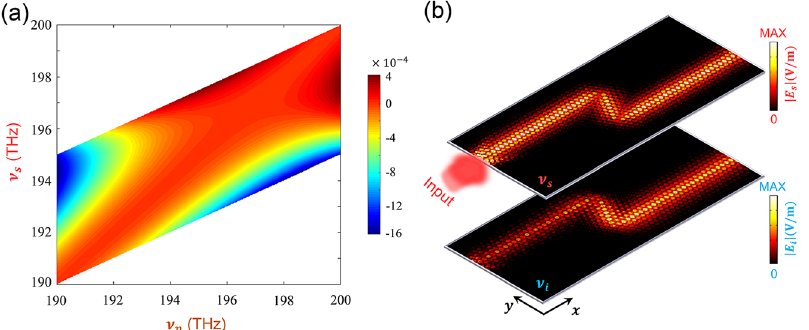
Figure 3: Topologically protected FWM interaction of valley kink